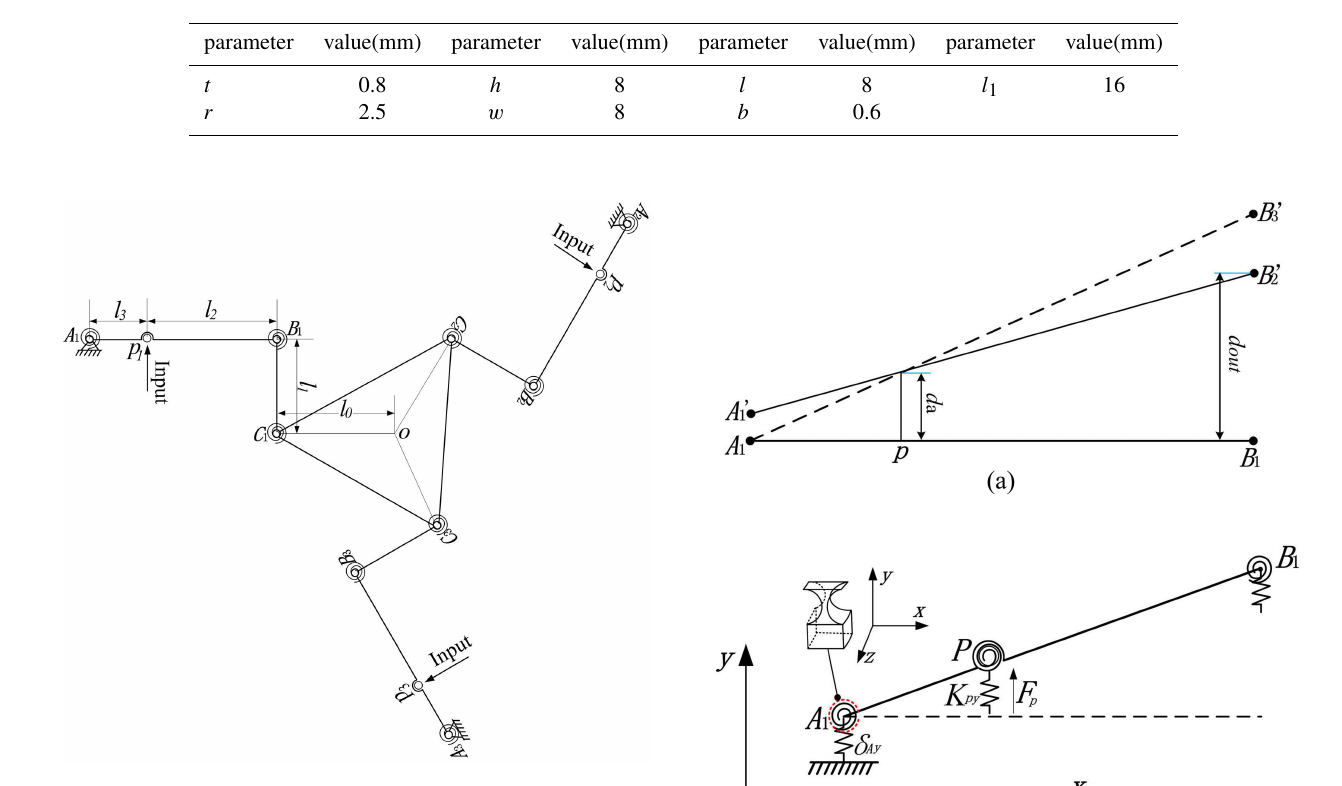
Table 1. Architectural parameters of the flexure hinges.